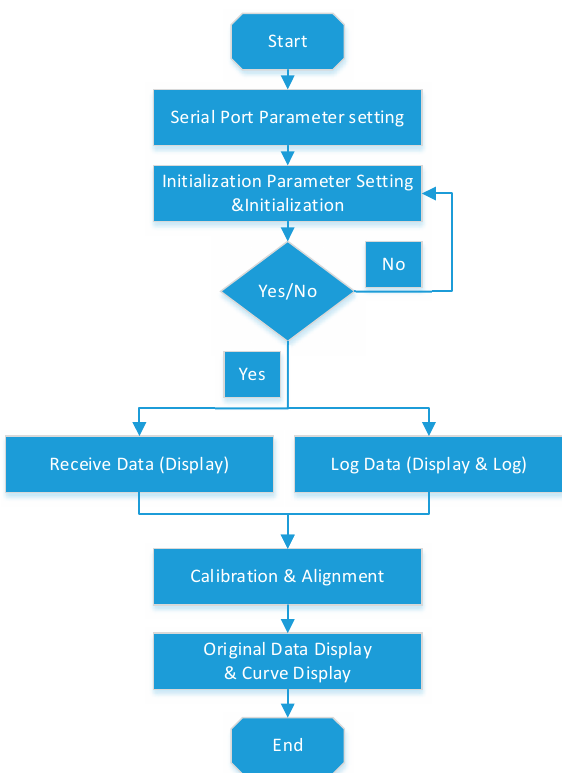
Figure 7. MGWD data collection software process flow diagram.